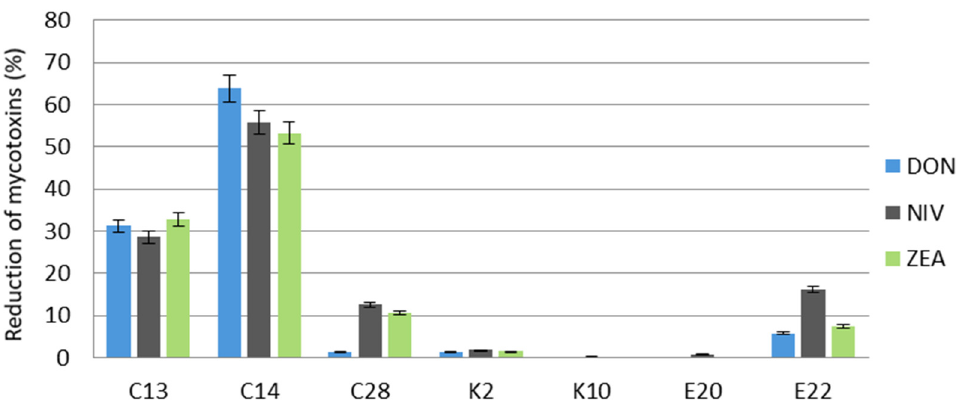
Table 1. Mycotoxin contents in wheat grain after 14 days of incubation (28 °C) of F. culmorum with the test yeasts.